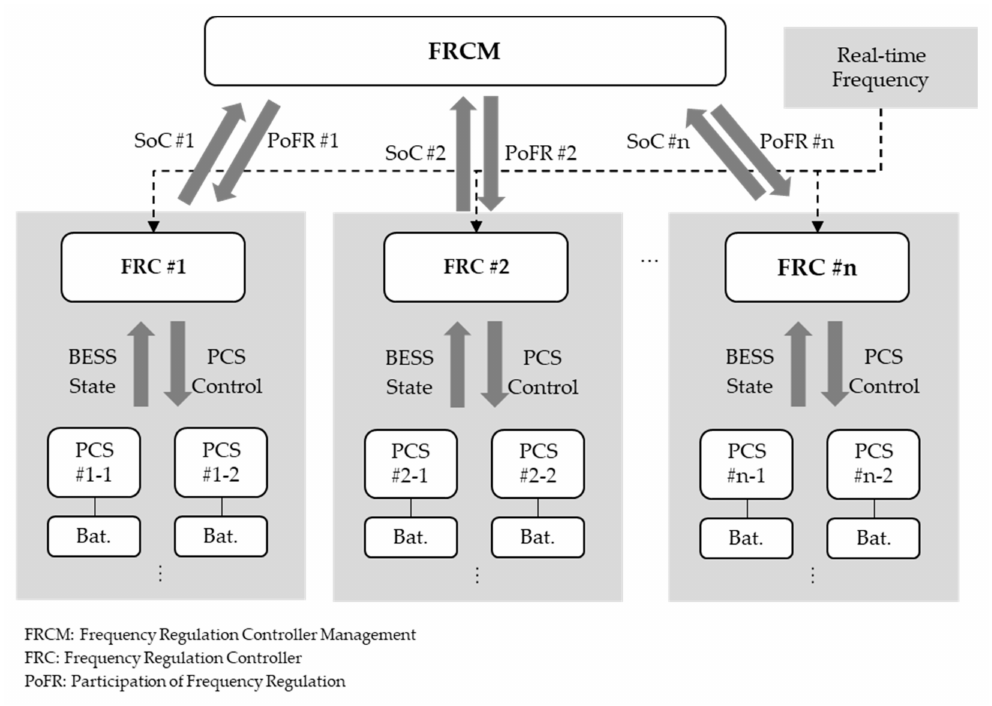
Figure 3. Existing configuration of the BESS for frequency regulation